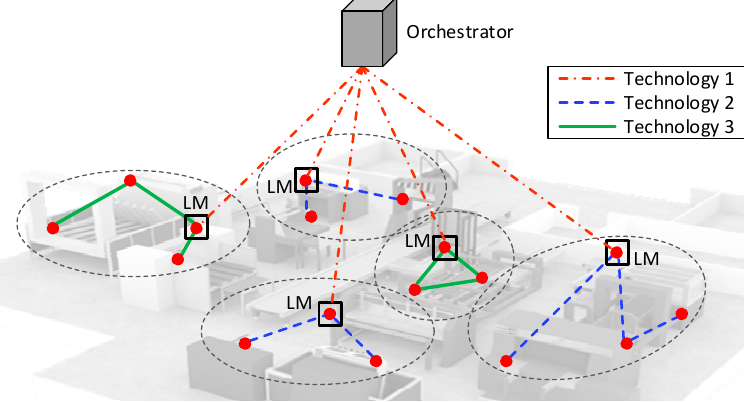
Figure 4. Hierarchical and heterogeneous Industrial Wireless Network architecture.